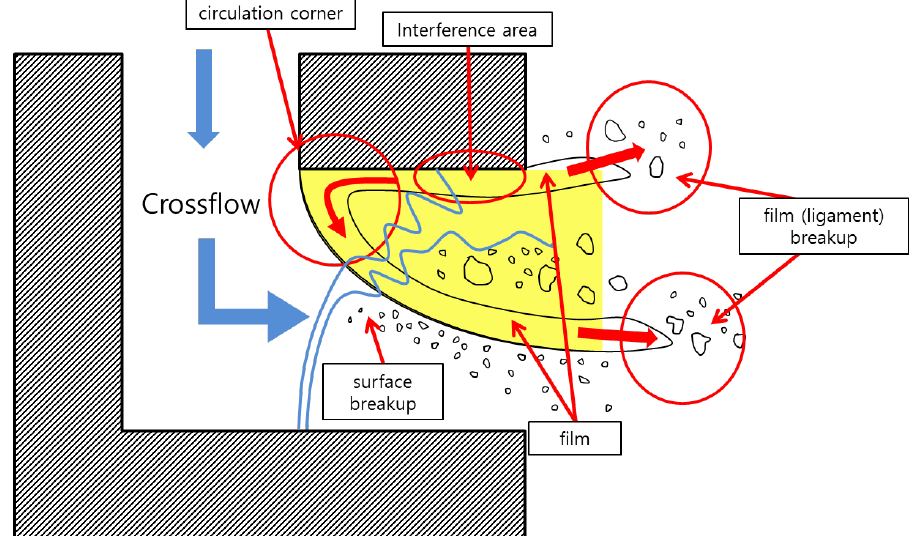
Figure 15. Schematic diagram of the jet breakup mechanism in the L-shape channel, which simulates a radial swirler.